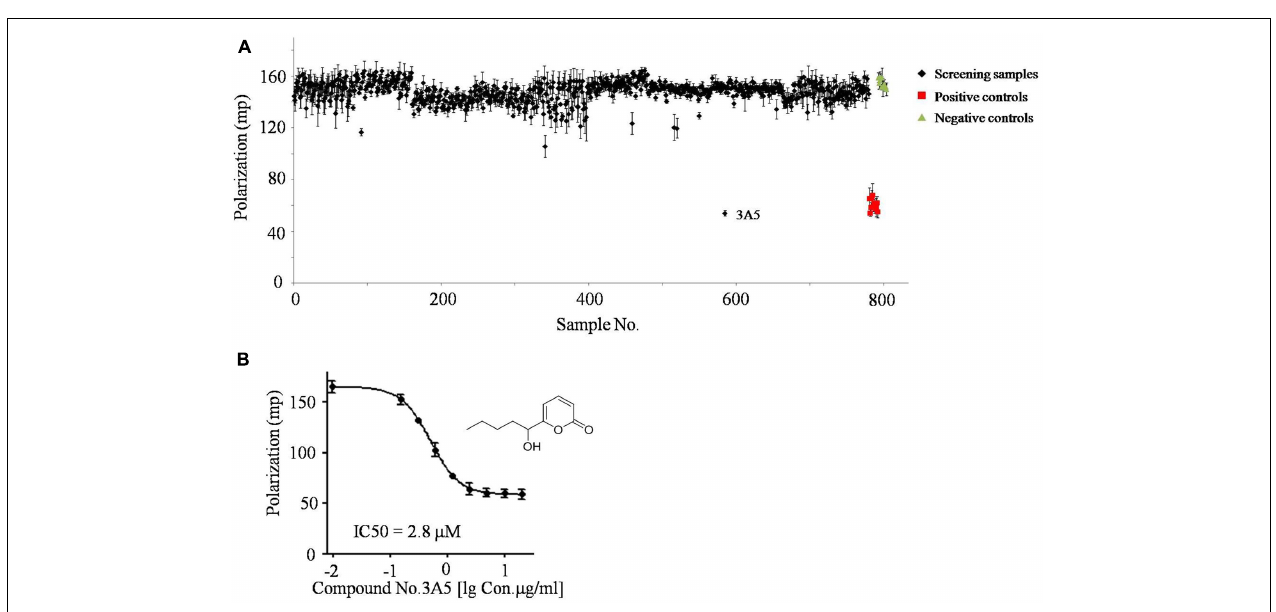
FIGURE 1 | Purification and binding assays of NS3h with nucleic acids. (A) Coomassie stained SDS-PAGE gel analysis of purified NS3h. Molecular weight (MW) markers were shown in kilodaltons. (B) Native agarose gel showing binding of NS3h to nucleic acids. (C) The schematic diagram of FP based assay on the interaction between NS3h and ssDNA. (D) Fluorescence polarization of 40 positive control assays (100 mM primuline) and 40 negative control assays (DMSO).